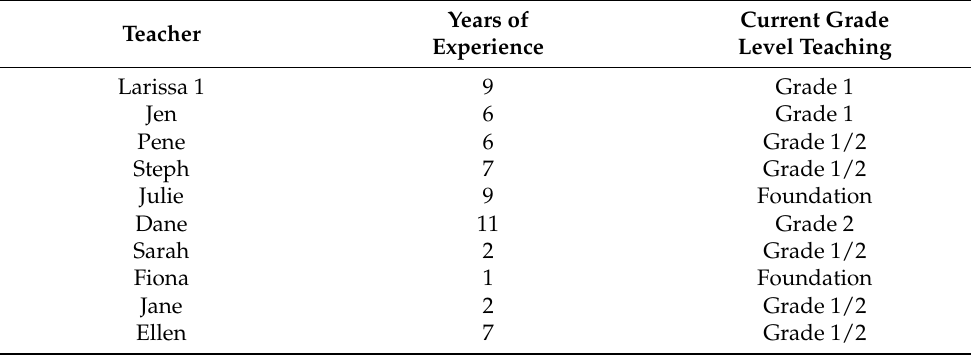
Table 1. Interviewees’ years of experience and current grade level